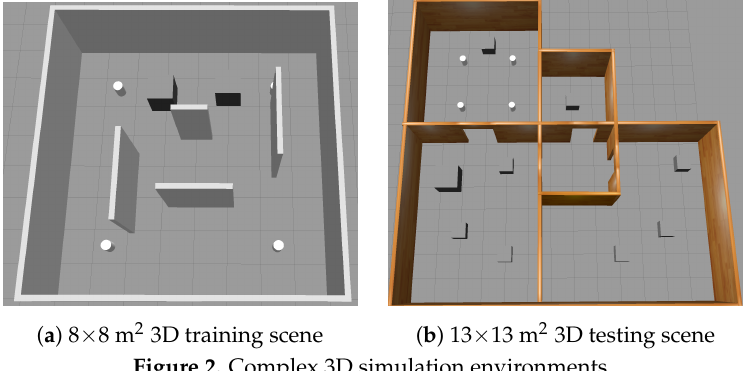
Figure 2. Complex 3D simulation environments.